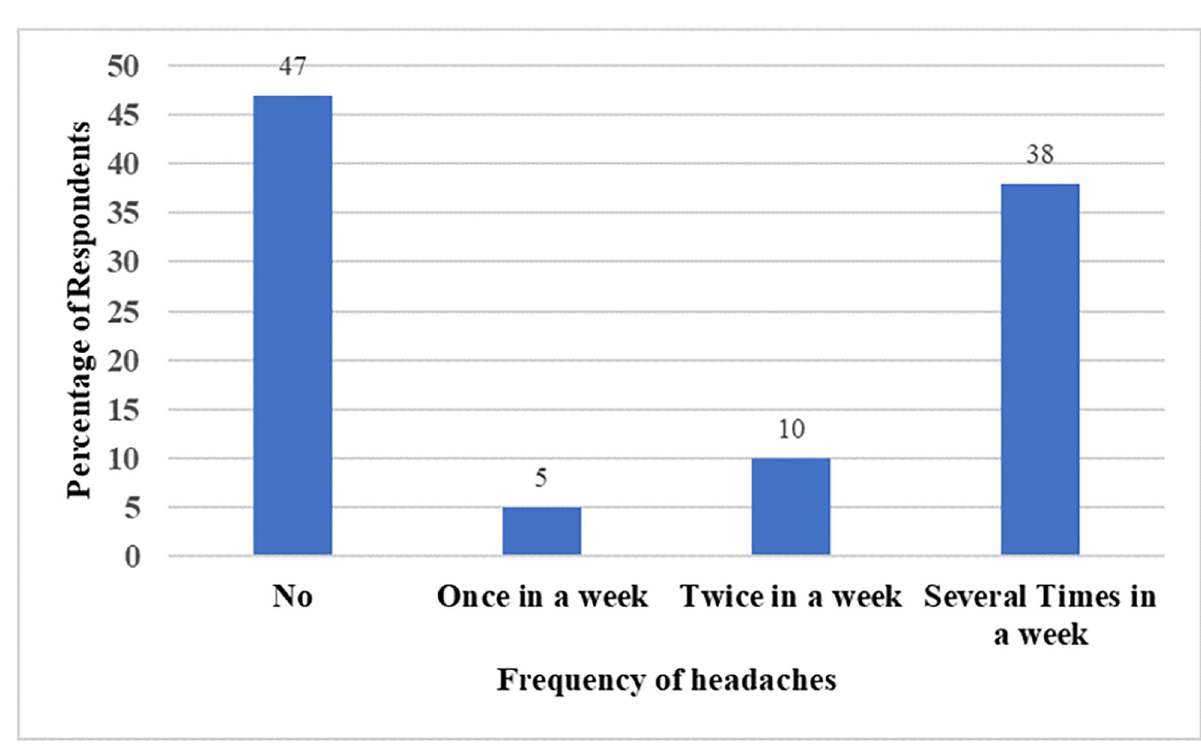
Fig 6. Association between fish smoking and headache.